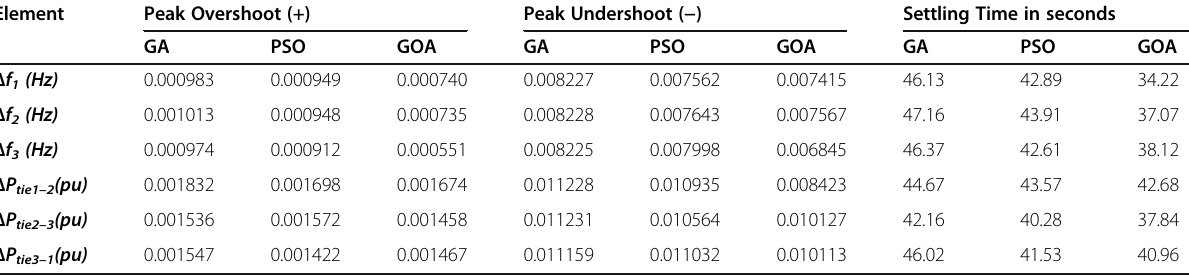
Table 3 Peak deviation and settling time for effectiveness measurement of GOA with PDF plus (1 + PI) controller Element Peak Overshoot (+) Peak Undershoot ( − ) Settling Time in